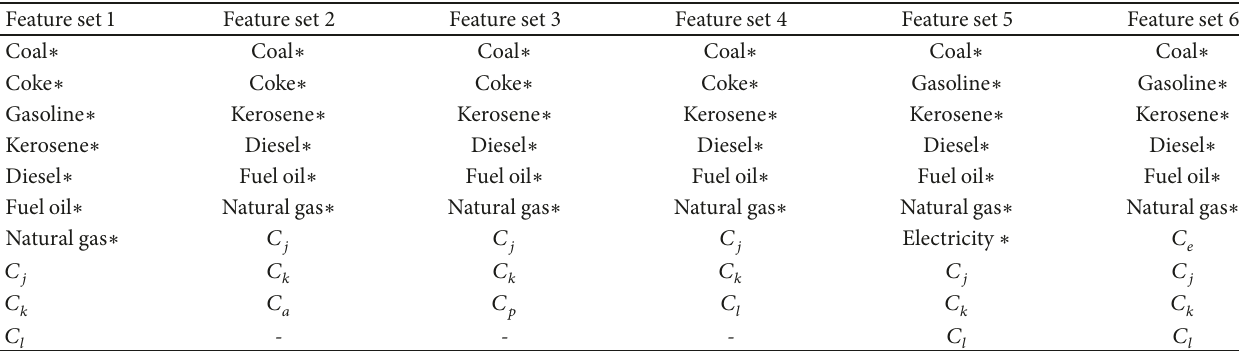
Table 5: Composition of variables in different